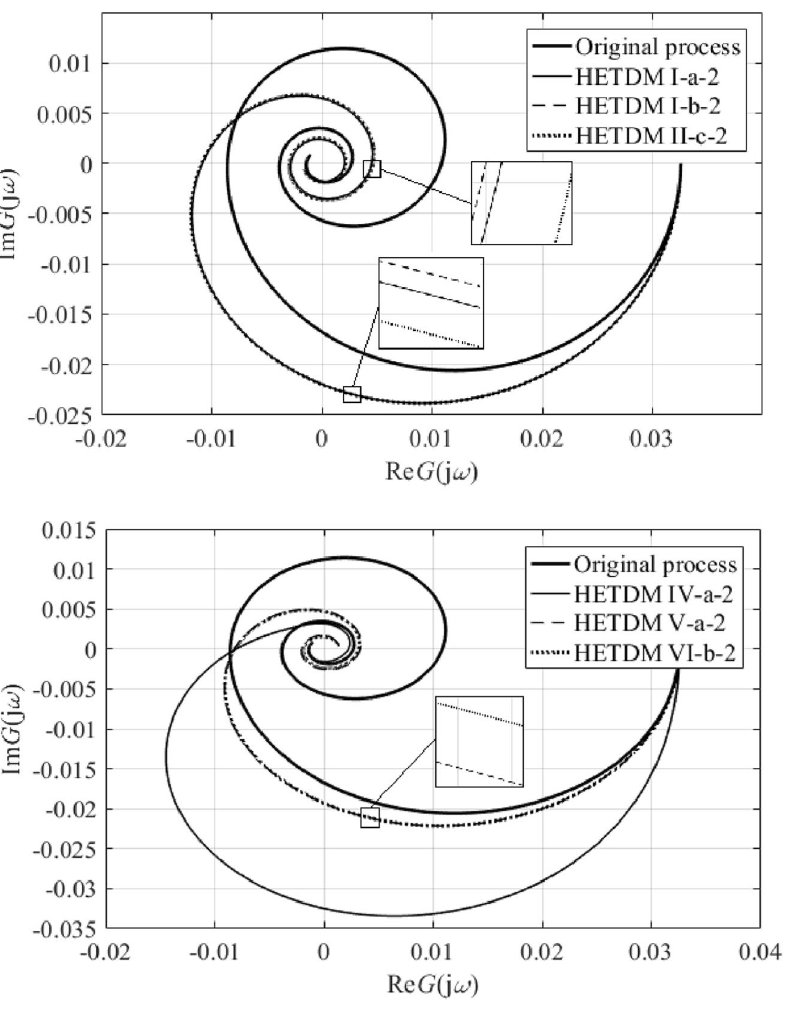
Figure 15. Comparison of selected HETDM Nyquist plots (vs. the original process response)—NM method used for transfer function numerator parameters